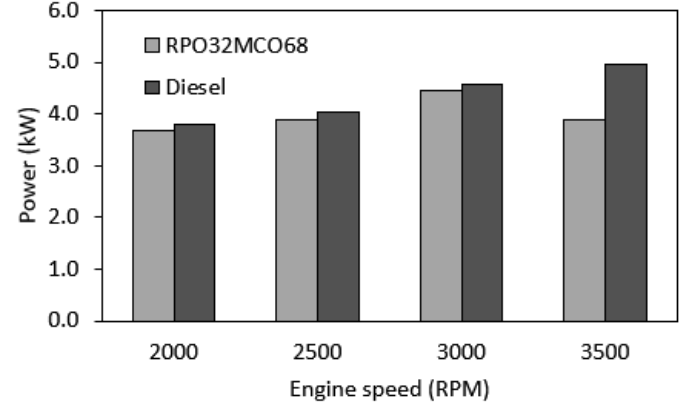
Figure 11. Comparison of engine power as a function of engine speeds.